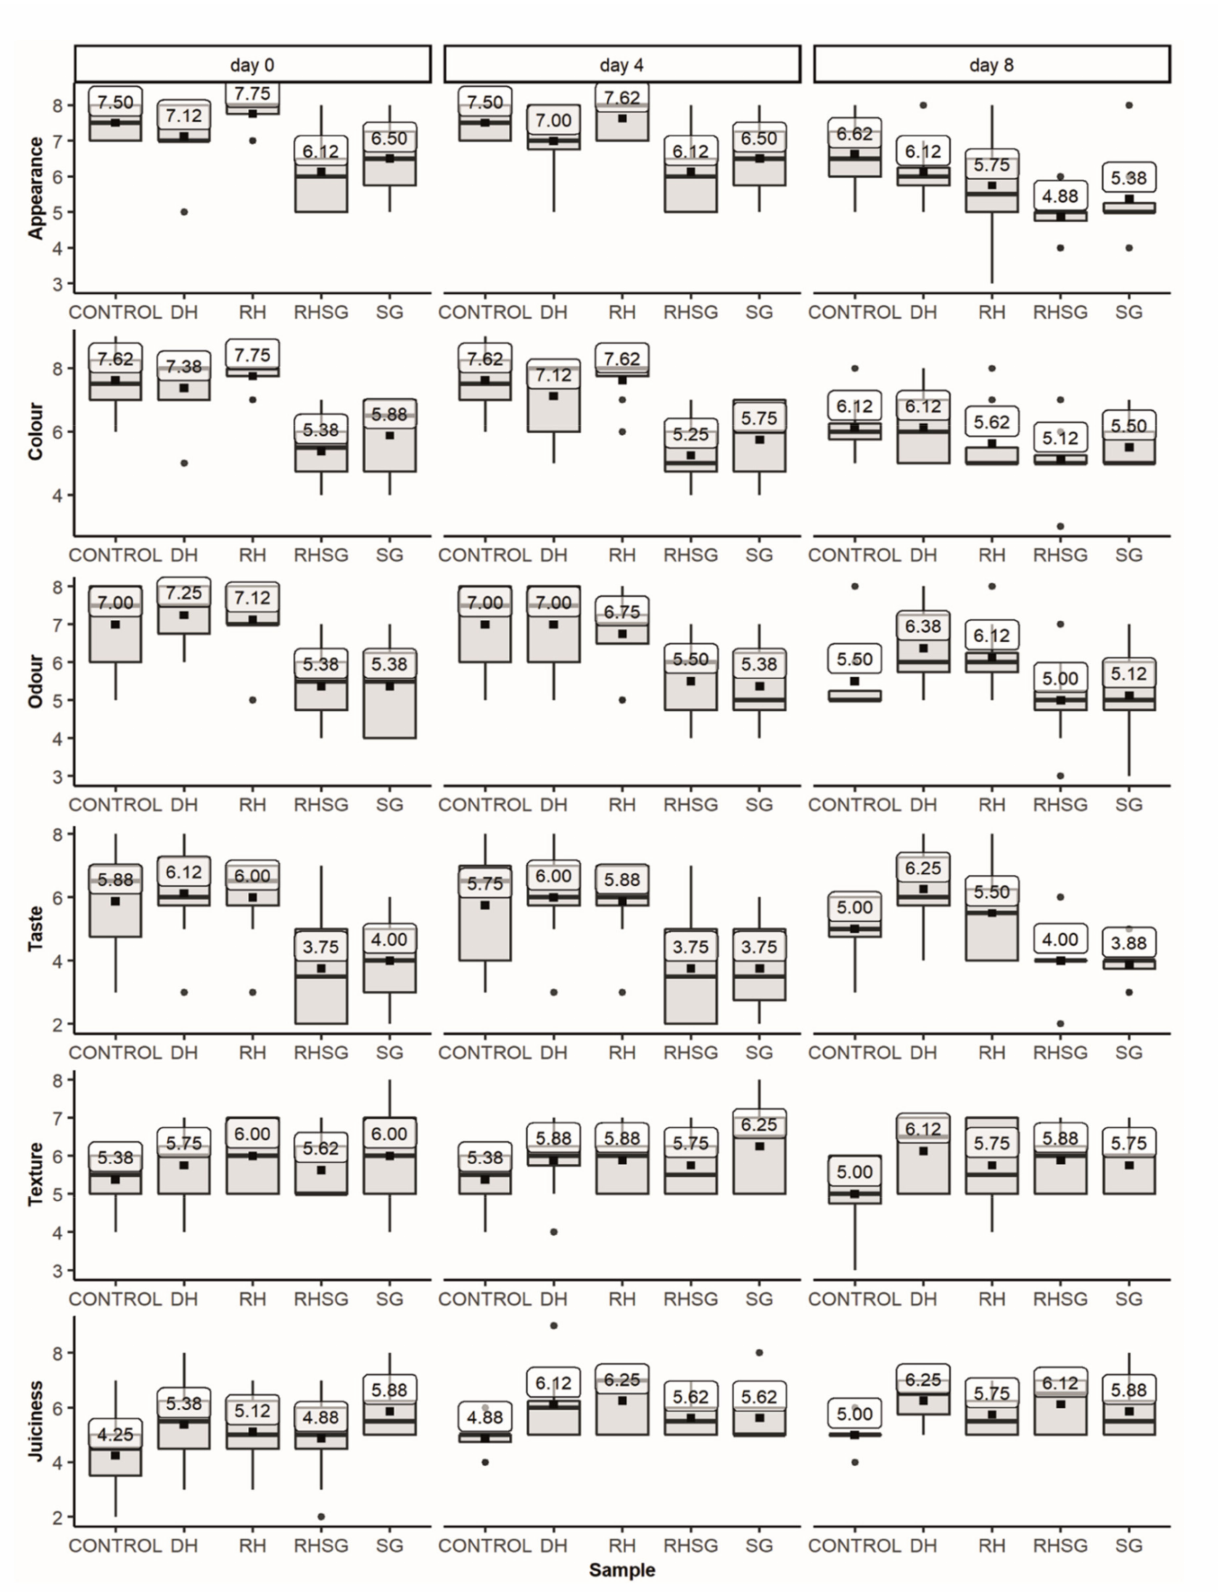
Figure 4. Sensory characteristics of grilled pork patties with different plant-based ingredients on storage days 0, 4, and 8 on the 9-point hedonic scale (control—without additives, RH—with 2% dried mechanically pressed hempseed cake, DH—with 2% defatted by supercritical CO 2 extraction hempseed cake, RHSG—with 0.5% sweet grass extract and 1.5% dried pressed hemp seedcake, and SG—0.5% sweet grass